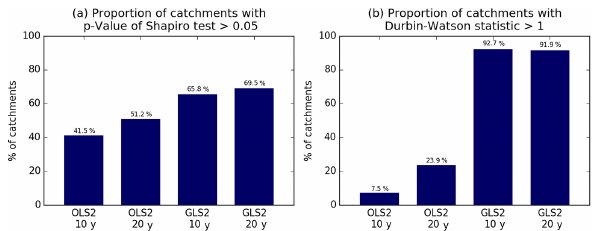
Figure B1. Proportion of catchments having a positive outcome for (a) the Shapiro–Wilks normality test and (b) the Durbin–Watson test on autocorrelation of